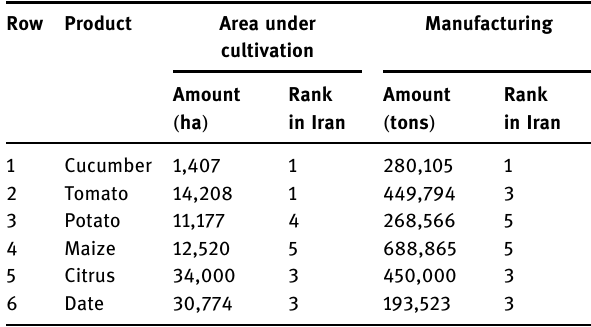
Table 1: Production status of products in